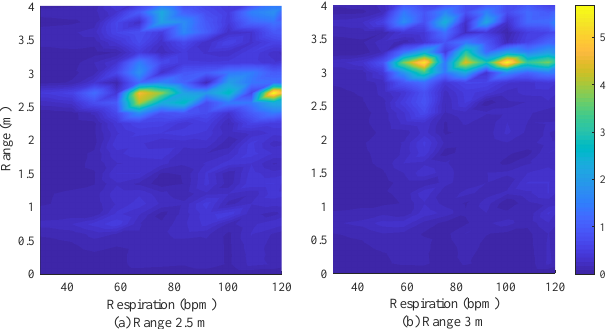
Figure 16. Experiment results of respiration rate and range